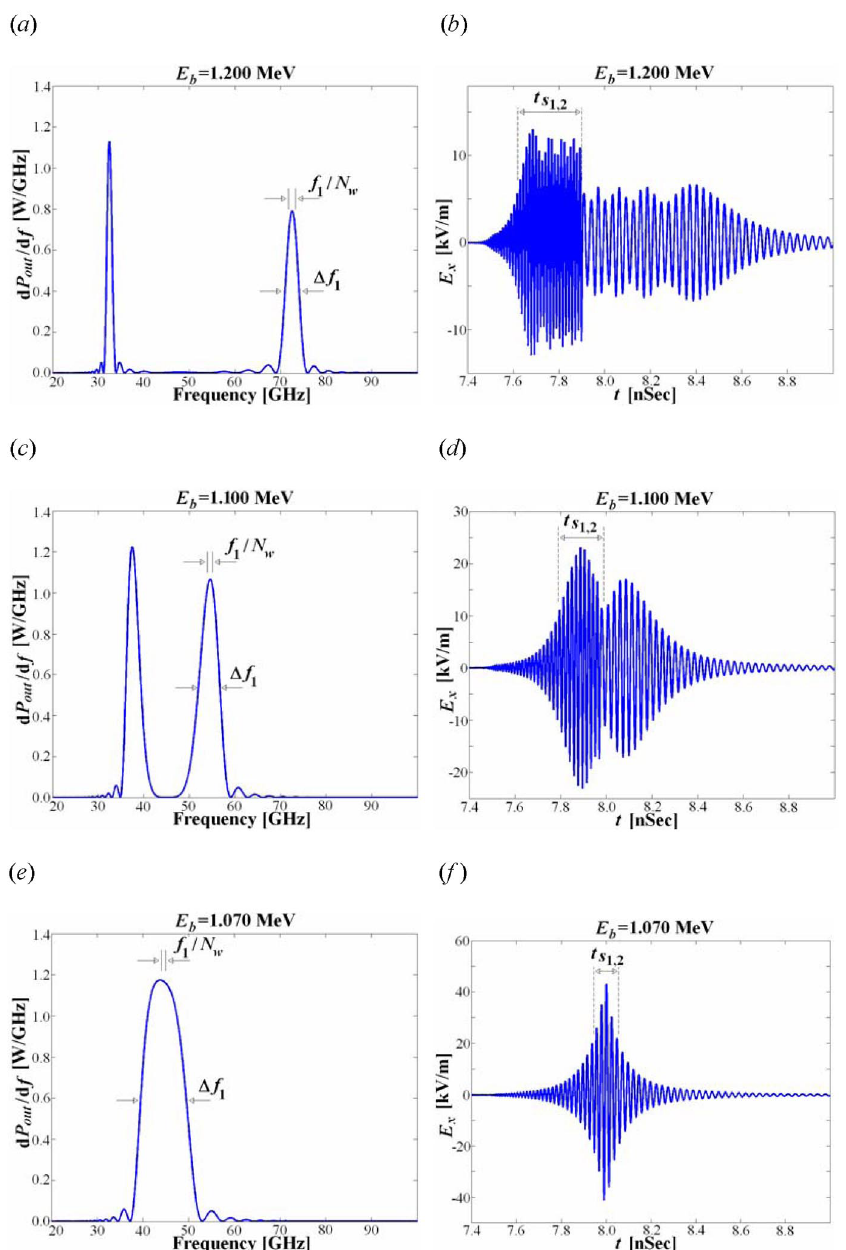
FIG. 6. (Color) The spectral power (a),(c),(e) and radiation field waveform (b),(d),(f) of a radiation wave packet emitted from a short e -beam bunch computed with an FEL code numerical simulation: (a),(b) E (cid:1) 1100 keV , near ‘‘grazing intersection’’; (e),(f) E (c),(d) E k